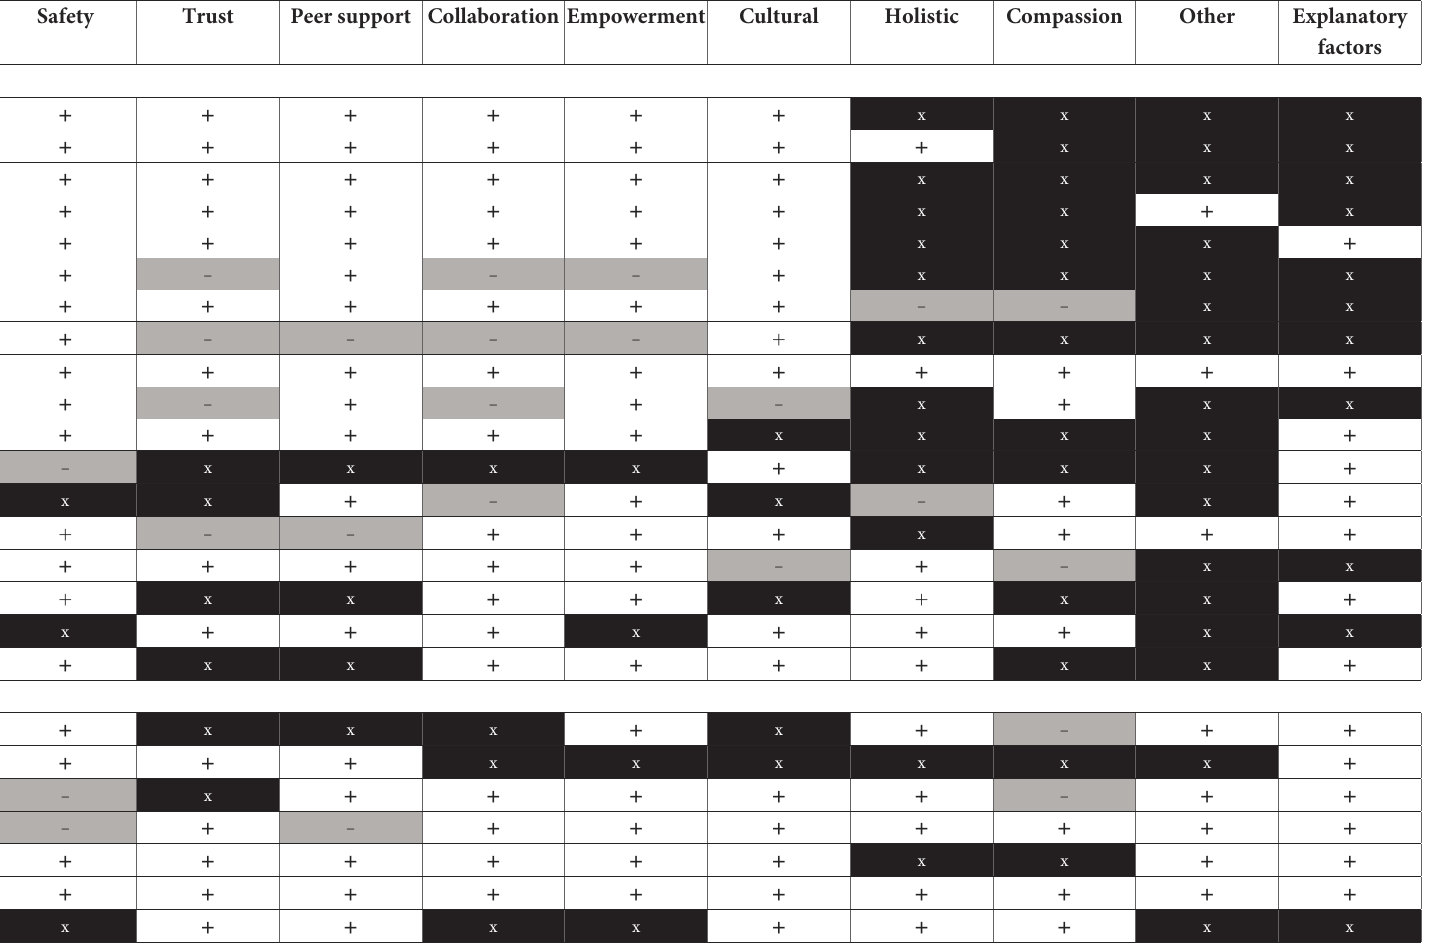
TABLE 2 Core conceptual